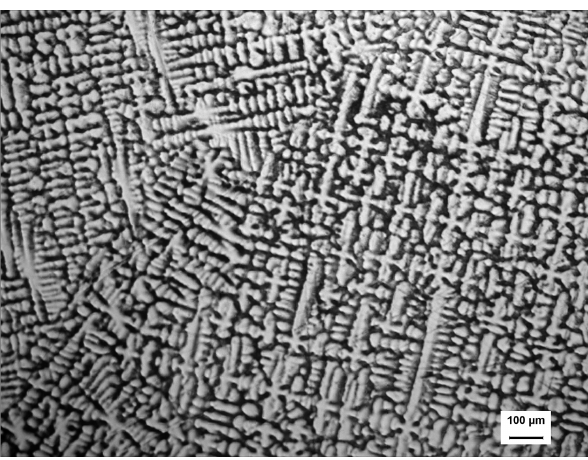
Figure 2: The microstructure of the original